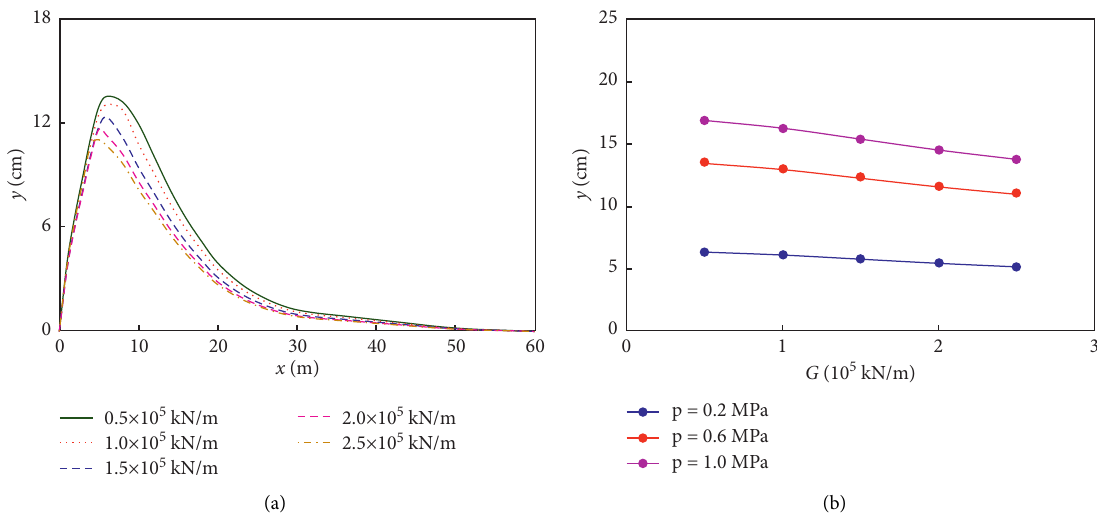
Figure 9: Influence of shear stiffness on the segment uplift: (a) variation of segment uplift under different values of G ; (b) relationship between the maximum segment uplift and G .